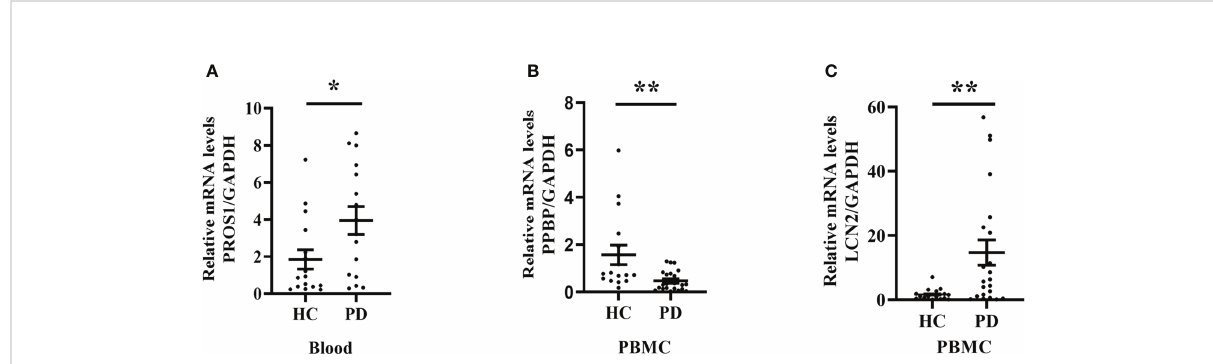
FIGURE 8 PROS1, PPBP, and LCN2 expression from PD patients and healthy controls. (A) The PROS1 expression in whole blood from PD (n = 16) was higher than HC (n = 16); (B) The PPBP expression in PBMC from PD (n = 22) was lower than HC (n = 16); (C) The LCN2 expression in PBMC from PD (n = 22) was higher than HC (n = 16). HC represents healthy controls, PD represents Parkinson ’ s disease. * p < 0.05, ** p < 0.01.